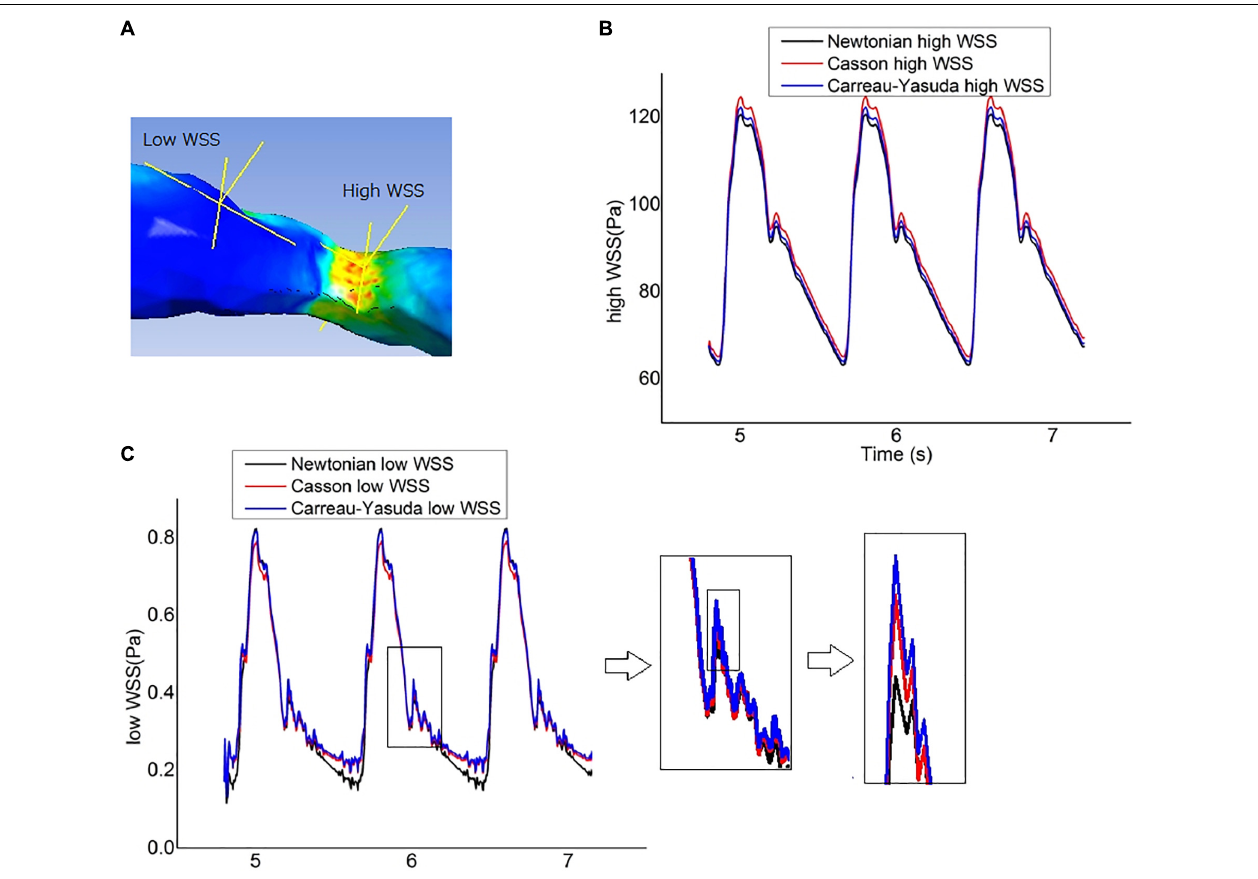
FIGURE 6 | Wall shear stress (WSS) measurement. (A) The locations of two points chosen to represent the high-WSS and low-WSS areas. (B) Curves of transient WSS during three cardiac cycles in Newtonian and non-Newtonian models, as measured at the representative high-WSS location. (C) Curves of transient WSS during three cardiac cycles as measured at the representative low-WSS location, which diverged in late diastole in Newtonian and non-Newtonian